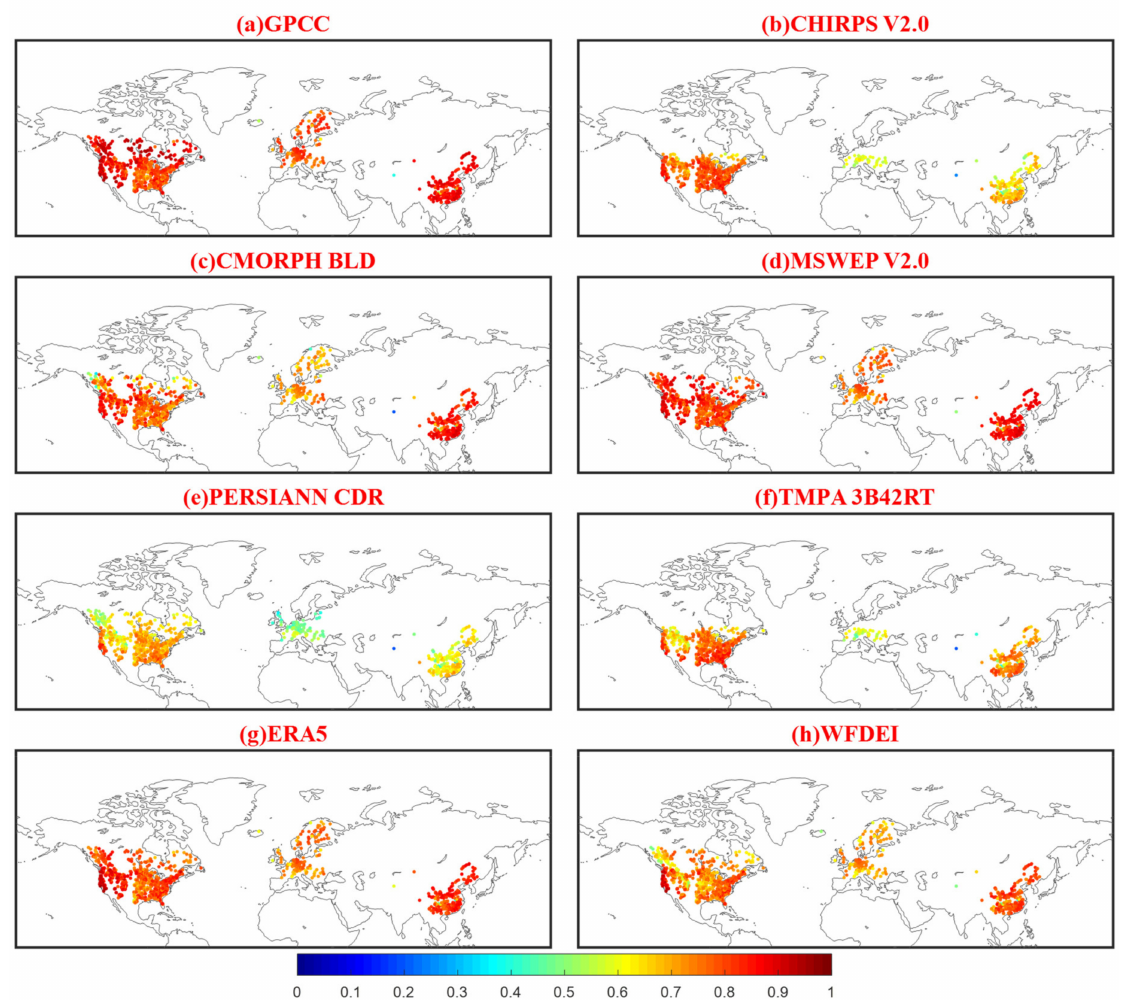
Figure 3. Spatial patterns of the R calculated for 3-day means (R 3day ) for the eight PPs (( a ) GPCC, ( b ) CHIRPS V2.0, ( c ) CMORPH BLD, ( d ) MSWEP V2.0, ( e ) PERSIANN CDR, ( f ) TMPA 3B42RT, ( g ) ERA5, ( h ) WFDEI) using gauge-observed precipitation from 1382 catchments as a reference. Each data point represents a catchment